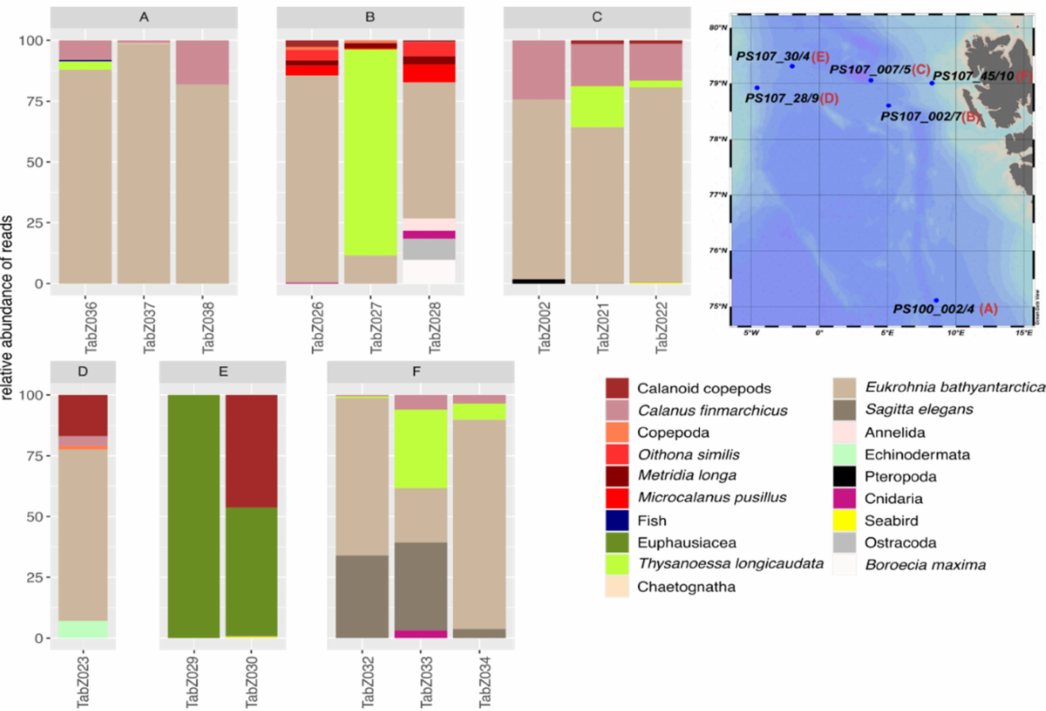
Figure 5. Prey spectrum found in the stomachs of T. abyssorum at different stations. Number of reads are given in relative abundances of reads per sample (RA); colors indicate different prey items; names of x-axis indicate sample IDs. Prey items contributing less than 1% to the total prey reads are comprised to phylum level. Copepods shown in red, euphausiids shown in green and chaetognaths shown in beige and brown color variants. Stations are represented by letters A–F and are shown in the map.